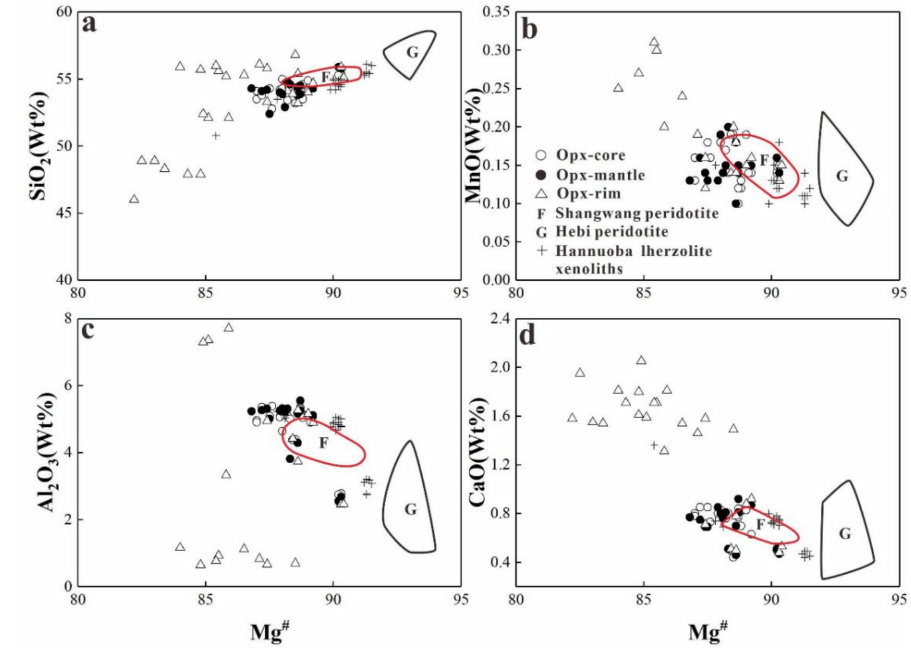
Figure 8. Plots of Mg # vs. SiO 2 ( a ), MnO ( b ), Al 2 O 3 ( c ) and CaO ( d ) for the orthopyroxene (Opx) in the websterite. Note: The Shanwang peridotite is characterized by a fertile mantle, which represents the newly-accreted lithospheric mantle [41]; the Hebi peridotite represents the remnant of the old cratonic lithospheric mantle